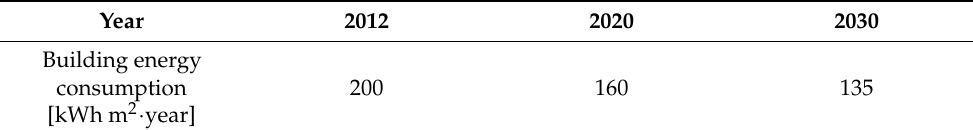
Table 1. The EU building energy consumption baseline value and trajectory by